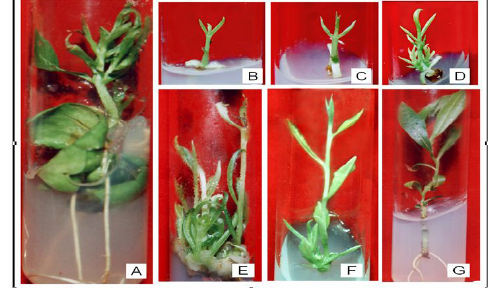
Fig. 1. Seed germination and Direct shoot regeneration from cotyledonary node of Soymida febrifuga ; (A) Raising of aseptic seedling on MS basal solid medium; (B) Single shoot initiation on MS medium with 3.0 mg l –1 BA after 5 days; Shoot prolif- eration on the same above medium after 10 days (C) after 15 days (D); (E) Multiple shoot production on the same medium after 5 weeks; (F) Elongated shoot on medium containing 2.0 mg l –1 BA and 2.0 mg l –1 Kn after 4 weeks; (G) In vitro rooting of S. febrifuga on MS half strength medium containing 556 mg l -l Ca (NO3) 2 + 1.0 mg l -l calcium pantothenate + 2.0 mg l -l IBA+2.0mgl -l IAA after 7 weeks